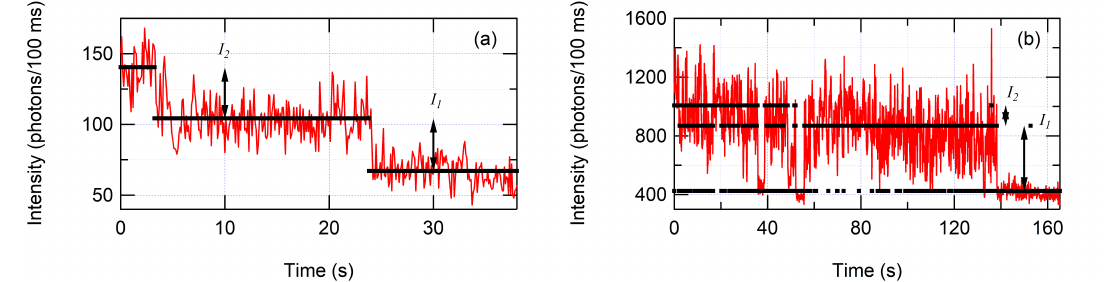
Figure 4. Three-state photon trajectories for ( a ) Atto647 on glass and ( b ) Atto647 in ZMWs. The over- laid Viterbi reconstruction is scaled to the average intensities. The intensities of Atto647 fluorescing states I 1 and I 2 are calculated as the difference between the average emission rates of adjacent states as indicated by arrows.